Question: What style of plot is this figure drawn as?
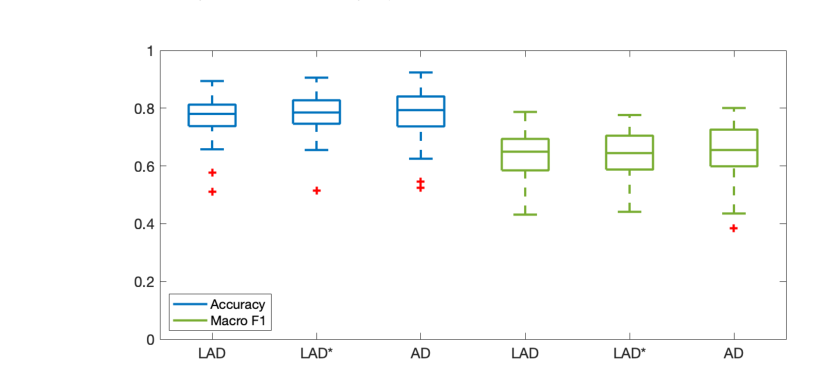
Answer: box